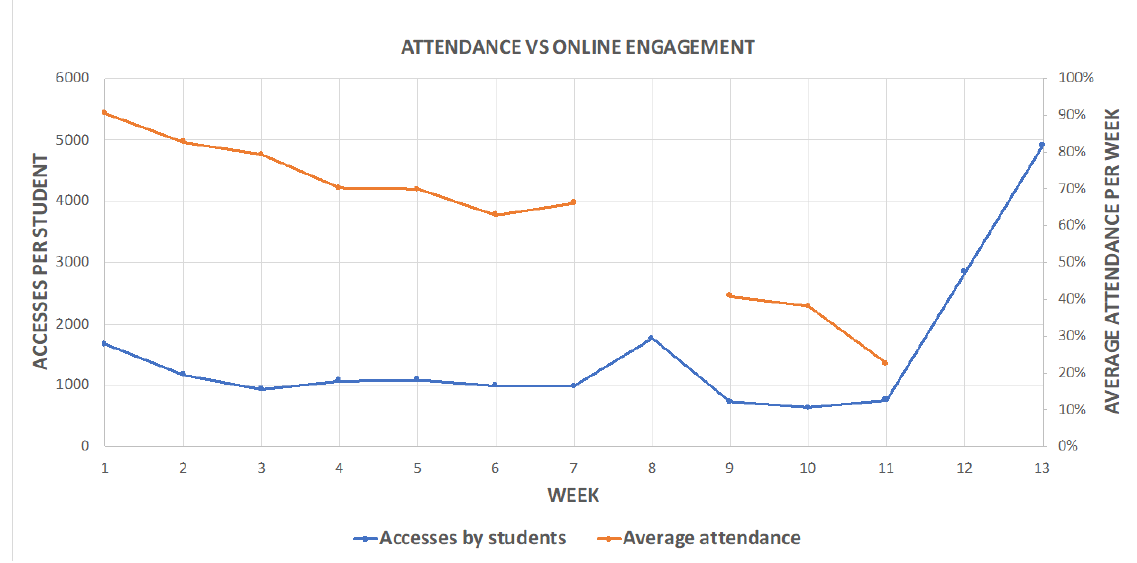
Figure 1 . Attendance vs Online